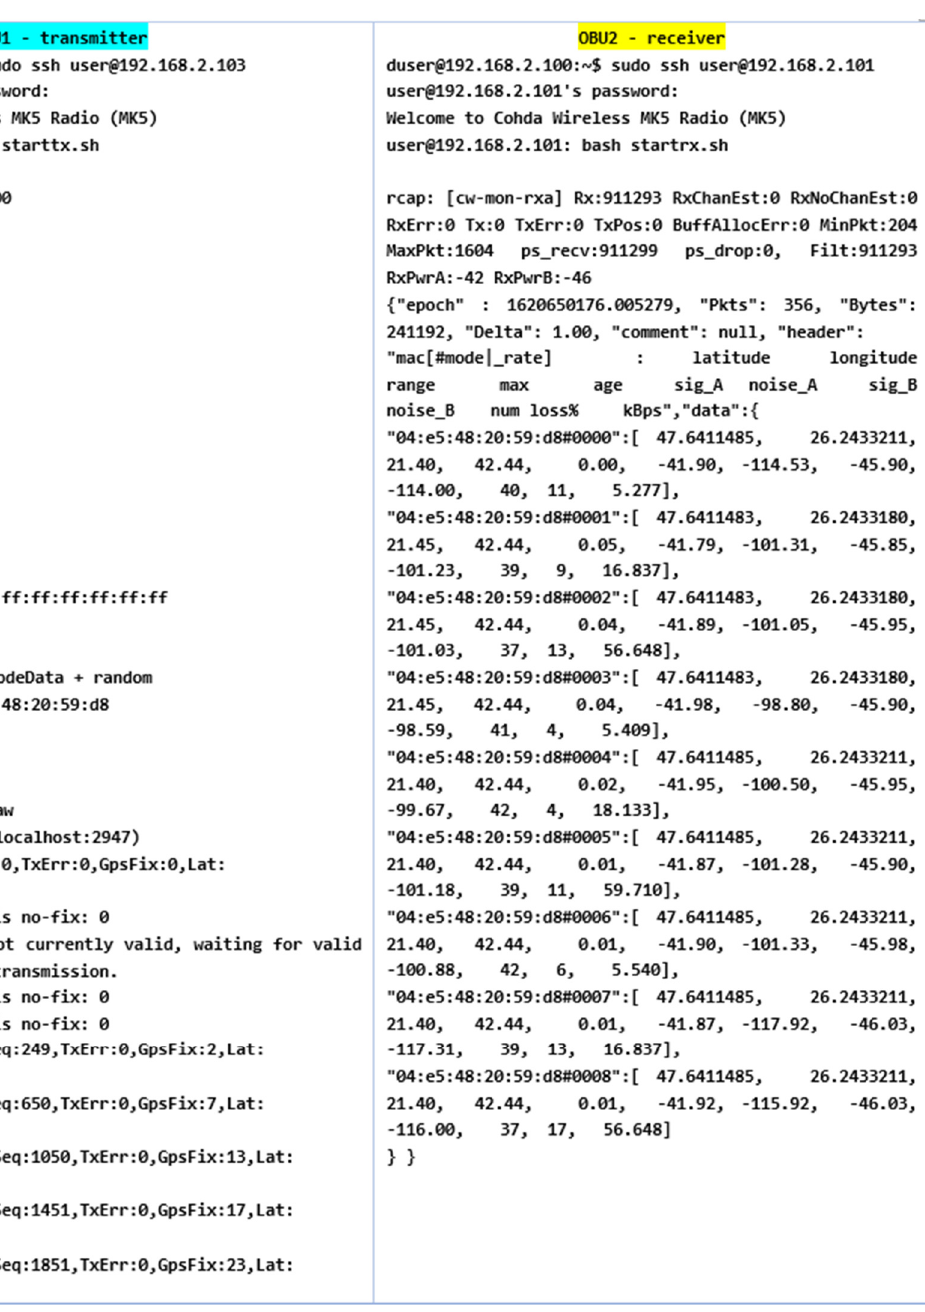
Figure 27. Synchronization algorithms between OBU 1 and OBU 2.